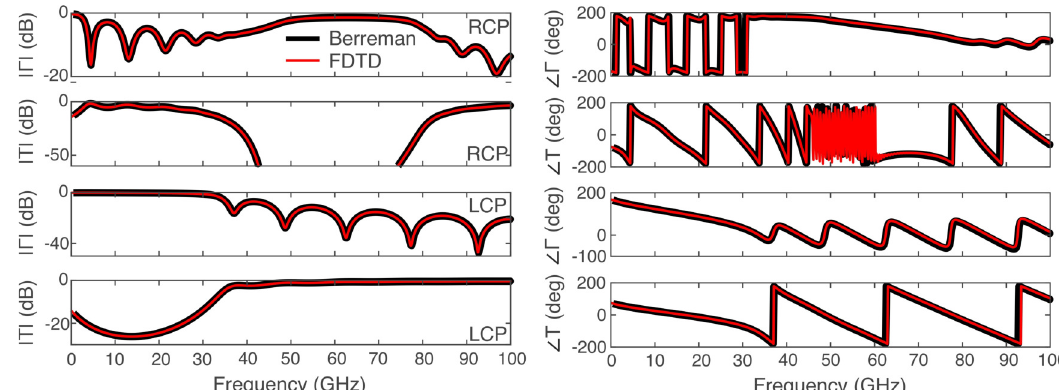
Figure 1. The magnitude and phase of the transmission/reflection coefficients for RCP/LCP waves propagating through magnetized plasma calculated by the proposed FDTD method and the Berreman 4 × 4 matrix